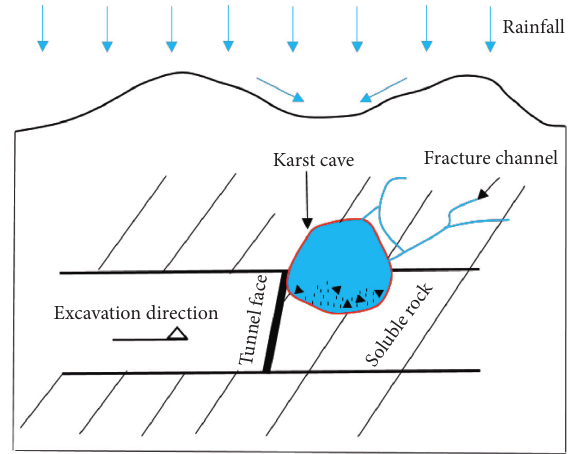
Figure 6: Diagram of water inrush in a karst